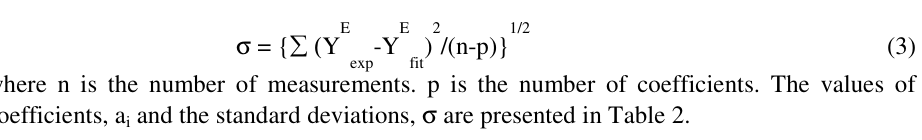
) and Excess Refractive Indexes (n E ) of exp